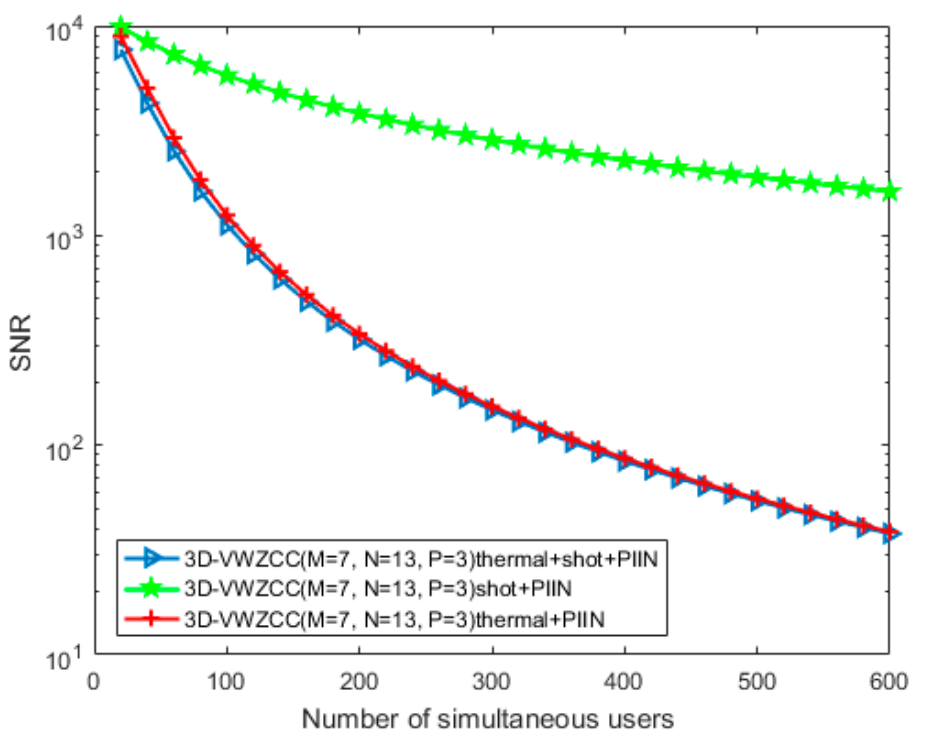
Figure 11. SNR versus number of simultaneous users when effective source power P sr = − 10 dBm and data rate R b = 1.25